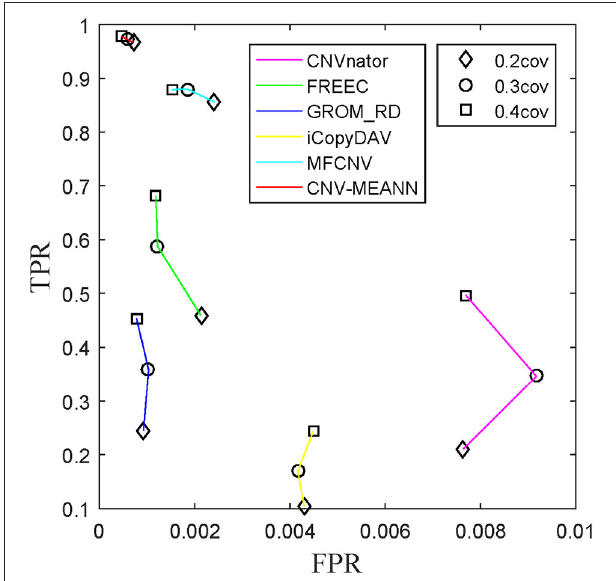
FIGURE 7 | ROC plots on simulation datasets between CNV-MEANN and five peer methods.